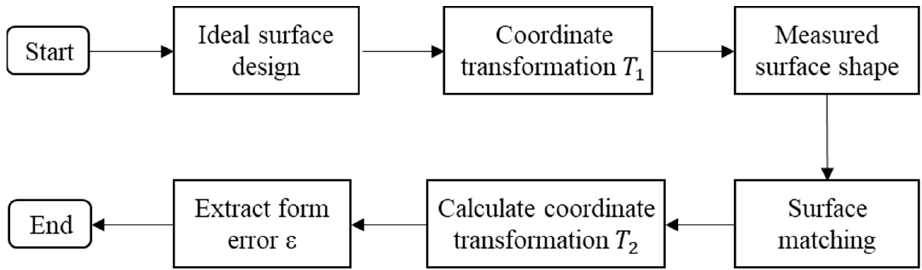
Figure 4. Flowchart of surface matching simulation.